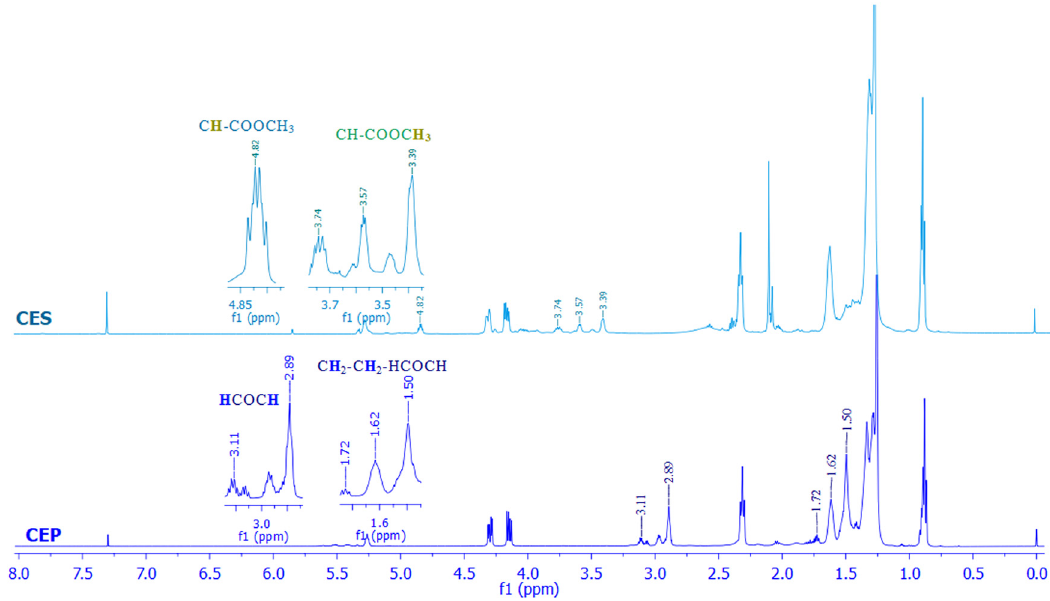
Figure 7: 1 H NMR spectra of CEP and CES